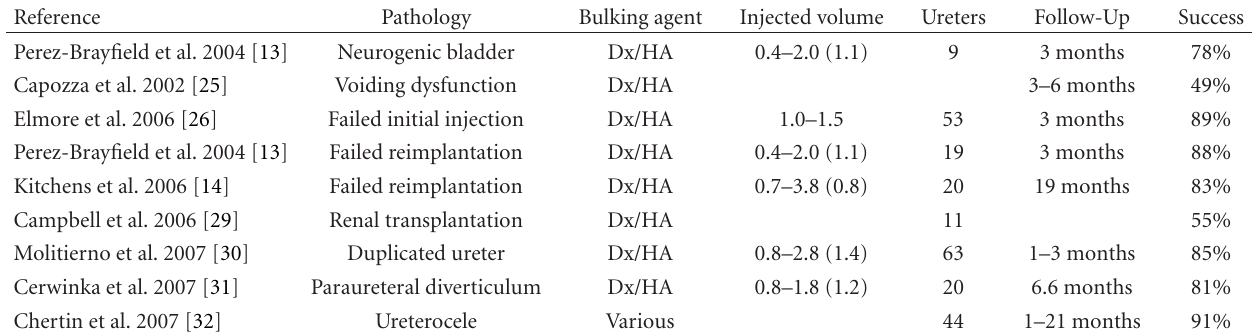
Table 2: Success rates of endoscopic treatment for complex